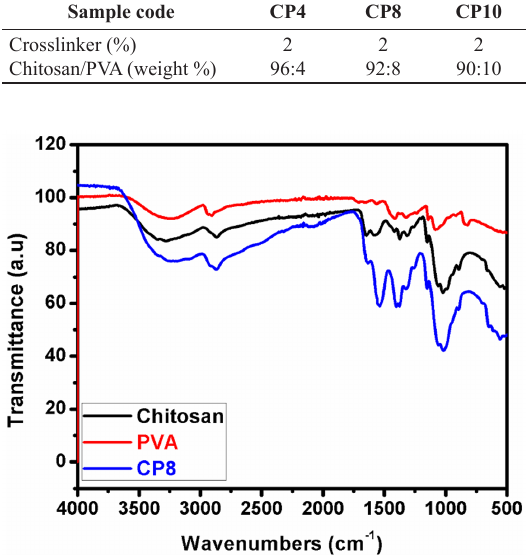
Figure 1. FTIR spectra of chitosan, PVA and